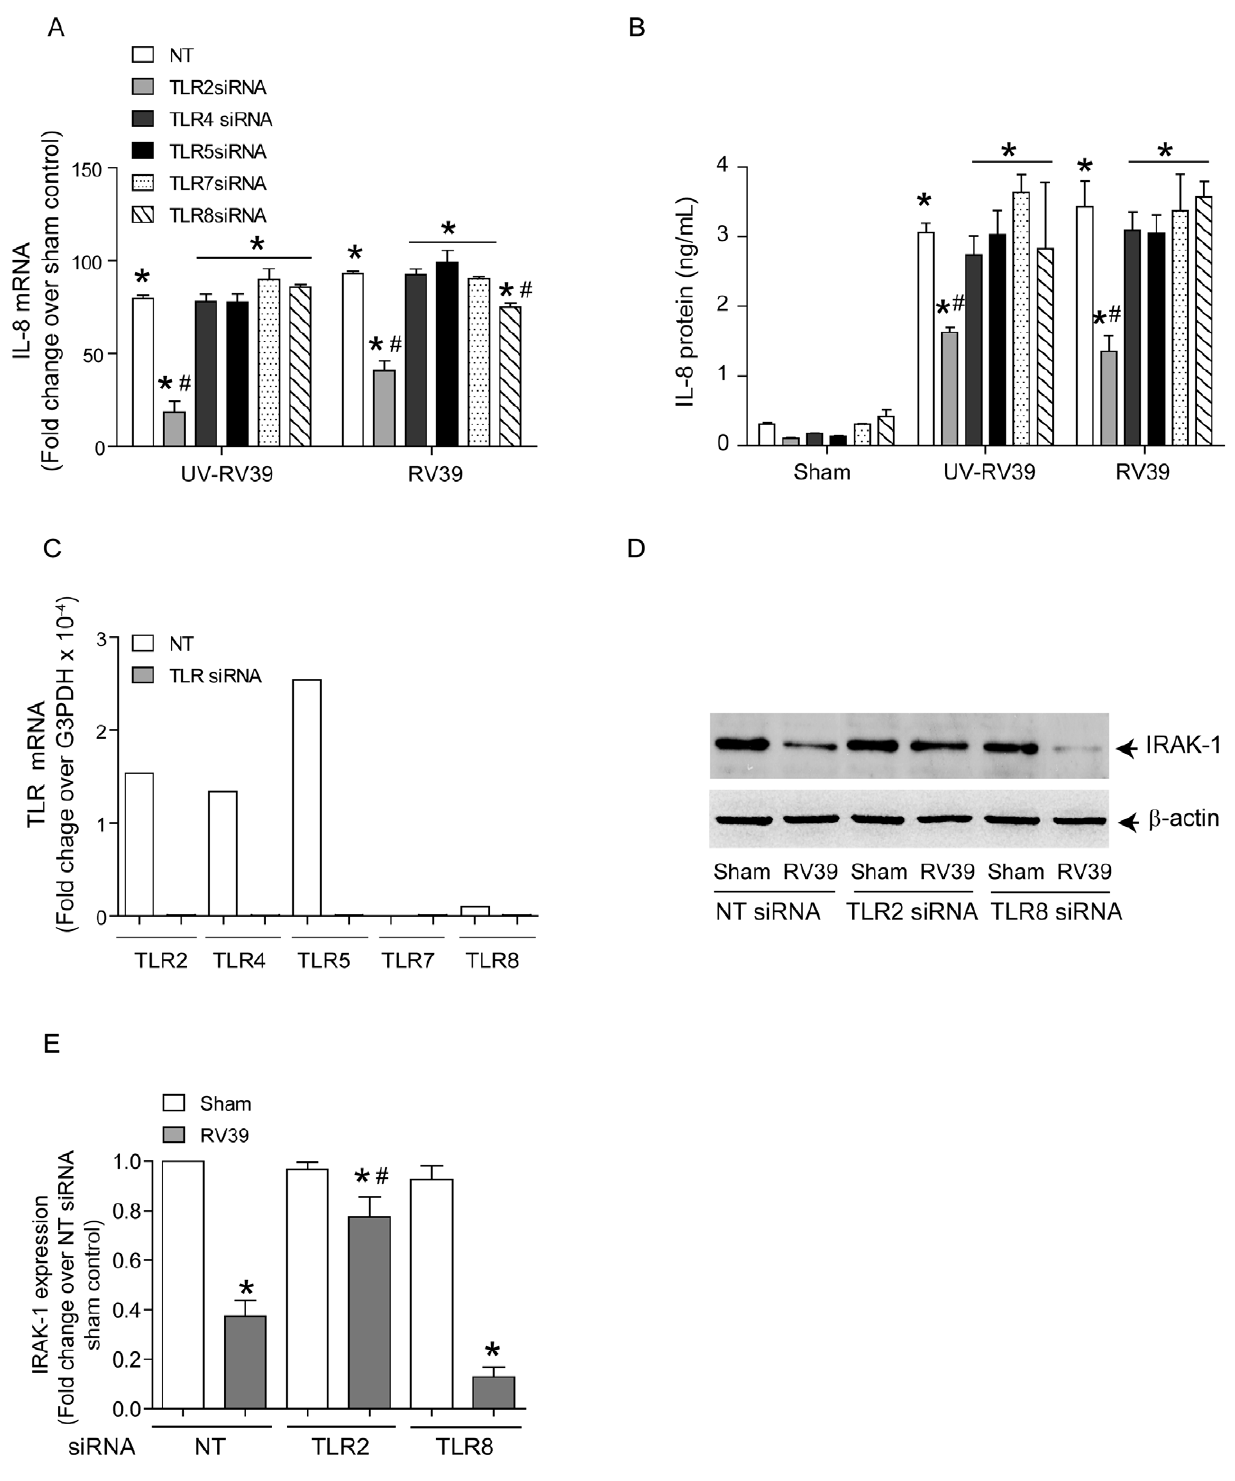
Figure 8. RV-decreases IRAK-1 protein via TLR2 activation. BEAS-2B cells were transfected with NT, TLR2, TLR4, TLR5, TLR7 or TLR8 siRNA and grown for 2 days. (A and B) Cells were infected with sham, UV-RV39 or RV39 and incubated for 24 h. mRNA and protein levels of IL-8 was determined by qPCR and ELISA respectively. (C) Knockdown of TLRs was confirmed by qPCR. Data is normalized to GAPDH and is representative of three independent experiments. (D) Cells transfected with NT-, TLR2 or TLR8 siRNA were infected with sham or RV39 as above and cell lysates subjected to Western blot analysis with IRAK-1 antibody. (E) Band intensities of IRAK-1 were normalized to b -actin and expressed as fold increase over respective NT/sham control. Image in D is representative of 3 independent experiments. Data in A, B and E represents mean 6 SEM calculated from 3 independent experiments performed in triplicate (* p # 0.05, ANOVA, different from sham; # p # 0.05, ANOVA, different from NT-siRNA transfected cells).